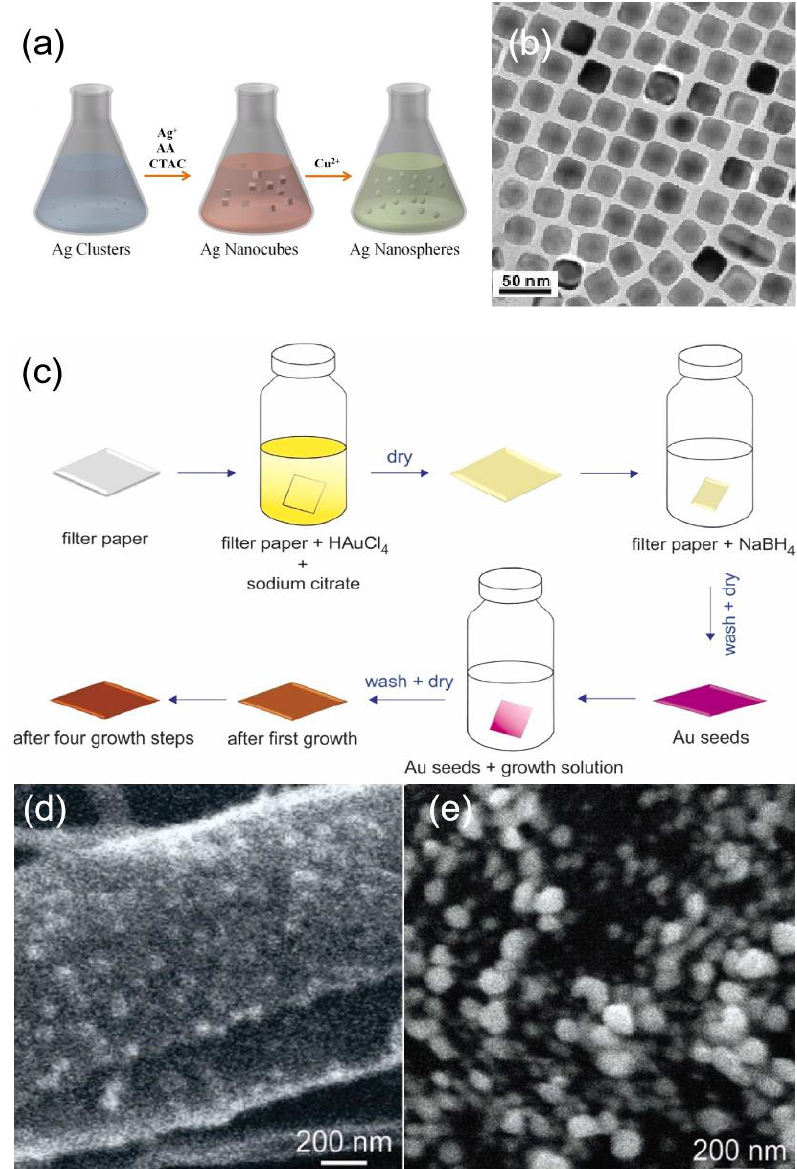
Figure 5. ( a ) Schematic illustration of the synthesis process of Ag NSs using a seed-mediated growth coupled with a chemical etching method. Reprinted with permission from Ref. [90]. Copyright 2018, Langmuir. ( b ) TEM image of Au@Ag nanocubes. Reprinted with permission from Ref. [93]. Copyright 2008, Journal of the American Chemical Society. ( c ) Schematic representation of the growth of Ag NPs on Au seeds. Reprinted with permission from Ref. [96]. Copyright 2022, Vibrational Spectroscopy. ( d ) substrate with 1st growth cycle. Reprinted with permission from Ref. [96]. Copyright 2022, Vibrational Spectroscopy. ( e ) SEM image of the substrate after the 4th growth cycle. Reprinted with permission from Ref. [96]. Copyright 2022, Vibrational Spectroscopy.